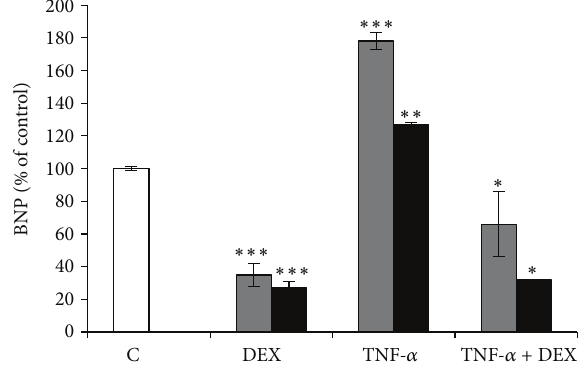
Figure 9: Dexamethasone effect on BNP expression. BEAS-2B cells were treated with 1 𝜇 M dexamethasone (DEX) and 40ng/mL TNF- 𝛼 alone or in combination with DEX, for 24 h. Histograms show BNP gene expression at mRNA (gray bars) and protein (black bars) level. All histograms indicate means ± SD of three different cultures each one tested in quadruplicate and expressed as percentage of control ( ∗ 𝑃 < 0.01 , ∗∗ 𝑃 < 0.001 , and ∗∗∗ 𝑃 < 0.0001 versus Controls). C: Controls (untreated